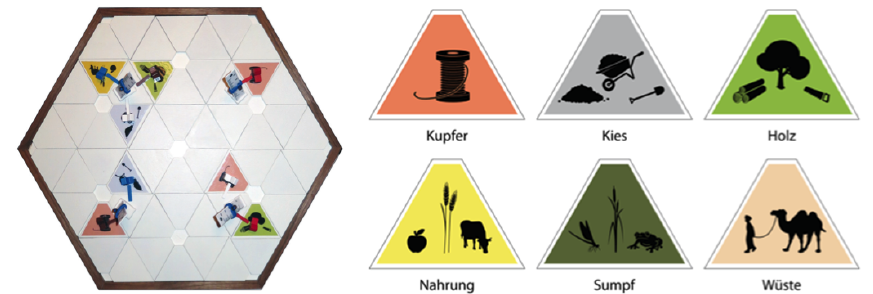
Figure 5. Board set-up for Wiapuna centered around four wells (left). Settlements are developed on different land use tiles (right), corre- sponding to the natural resource cards (copper – Kupfer, gravel – Kies, wood – Holz, food – Nahrung, marsh – Sumpf, and desert – Wüste) that are used to buy infrastructure and energy efficiency measures. Table 2. Each community in Habitat Ganges is given a sheet of paper indicating the list of prices for each resource (in arbitrary monetary units) together with the qualitative outcome ( ± ) for each of the indicators (economy, life quality, and water quality) needed to win the game (here only “Agriculture/fisheries” and “Industry” are shown for Calcutta resource prices, as an example). Resource Price/year Yield/year Effects Resource Budget Economy Quality Ganges of life water quality Agriculture/fisheries 60